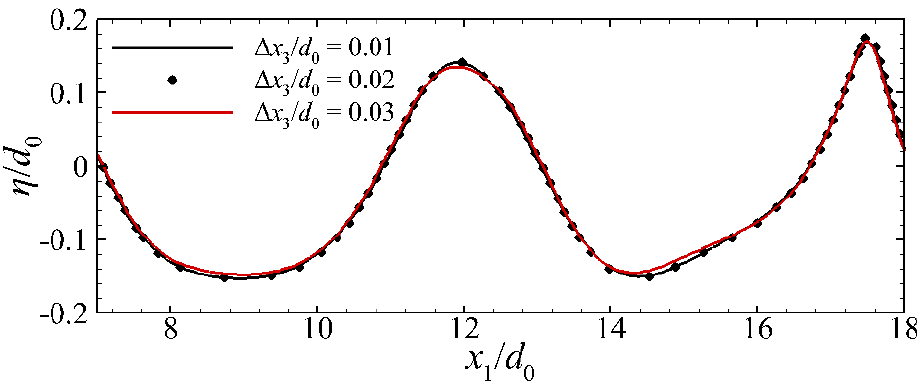
Figure 4. Instantaneous free ‐ surface elevation for Case 5 after five wave cycles from the beginning of the simulation for three vertical grid spacing values. Note that the axes are not in scale for clarity of the exposition.